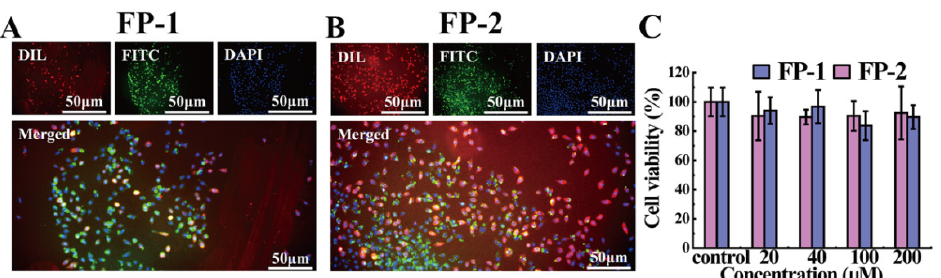
Figure 3. The interaction between the functional peptides of SARS-CoV-2 and the mouse fibroblast cell line (L929). ( A , B ) Fluorescence images of the mouse fibroblast cell line (L929)) treated with FP- 1 and FP-2. Size: 50 μm. ( C ) Cell viability of the mouse fibroblast cell line (L929) treated by the functional peptides with different concentrations, and error bars denote standard deviation (s.d.).